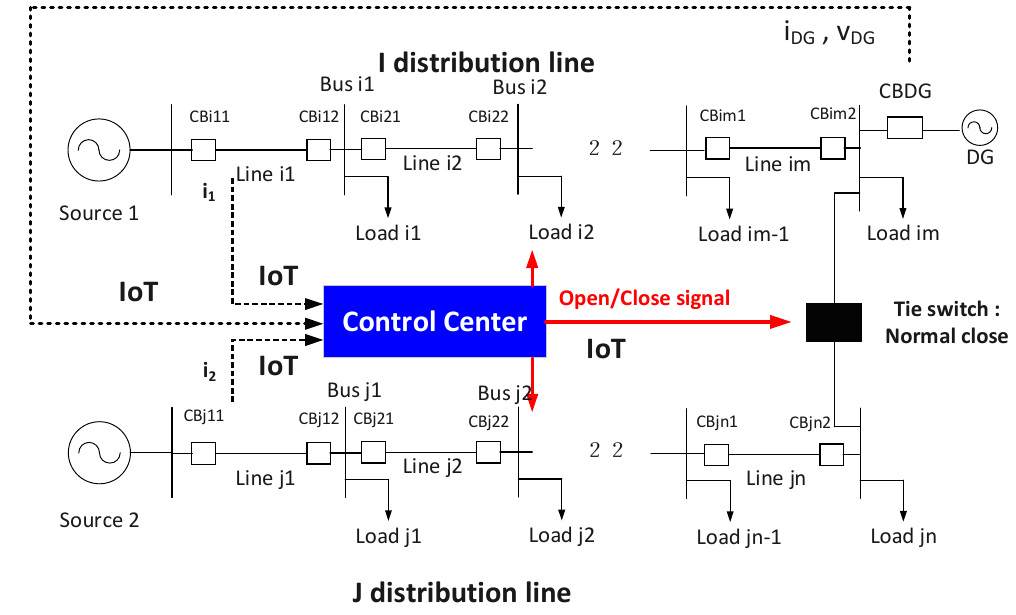
Figure 4. Schematic diagram of new protection method of the loop distribution system considering DG.